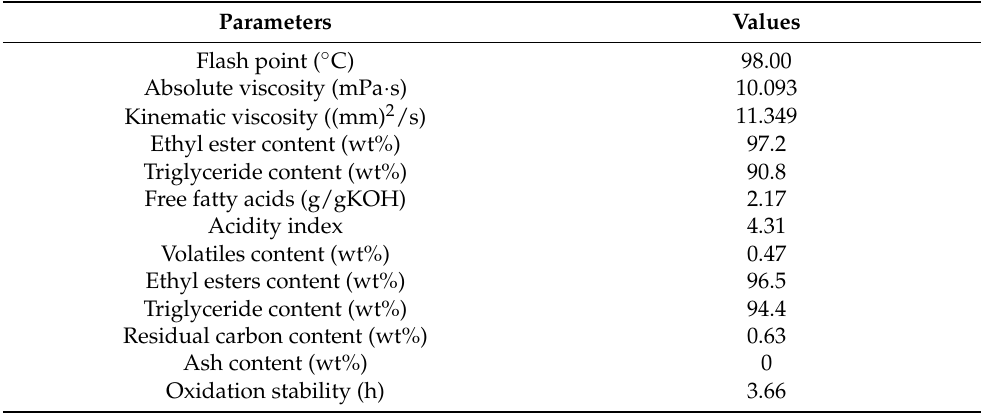
Table 5. Quality of the biodiesel obtained via transesterification of JCLO using microencapsulated recombinant lipase as